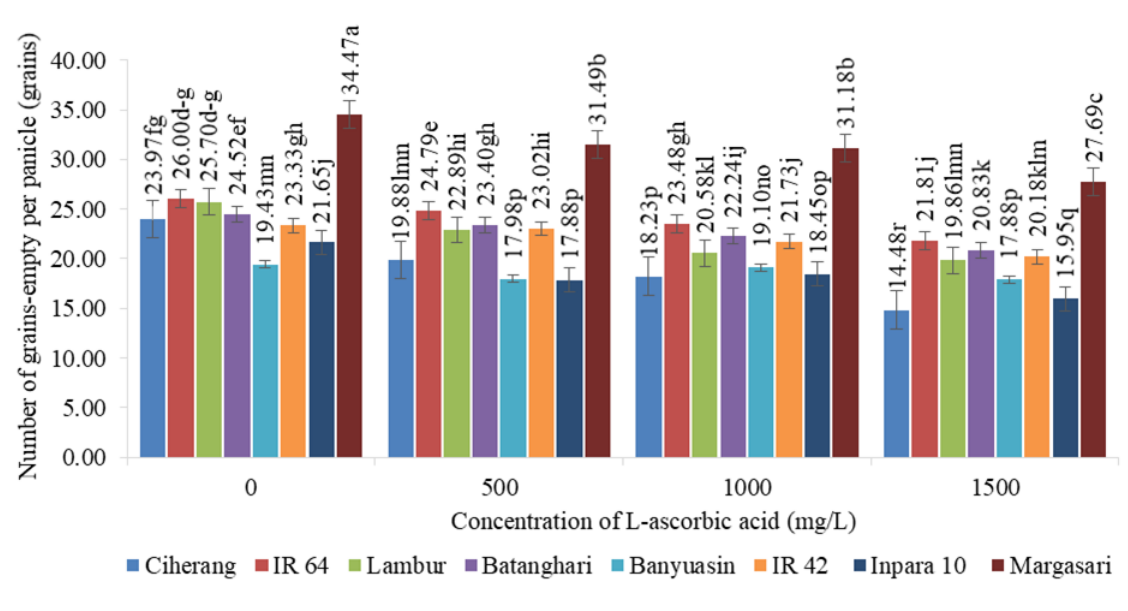
Figure 2 Effect of -ascorbic acid treatment on the number of empty grains per panicle of eight rice cultivars grown under salinity stress. e mean values followed by different letters indicate significant difference between treatments according to Duncan’s